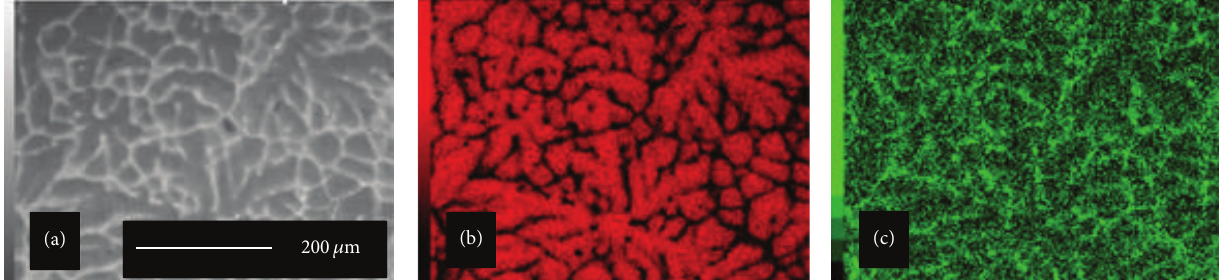
Figure4:X-raymappingofAl-25at.%Znalloyquenchedinliquidnitrogen.(a)Samplesurfacepriorcorrosion.(b)Distributionofaluminum. (c) Distribution of zinc.